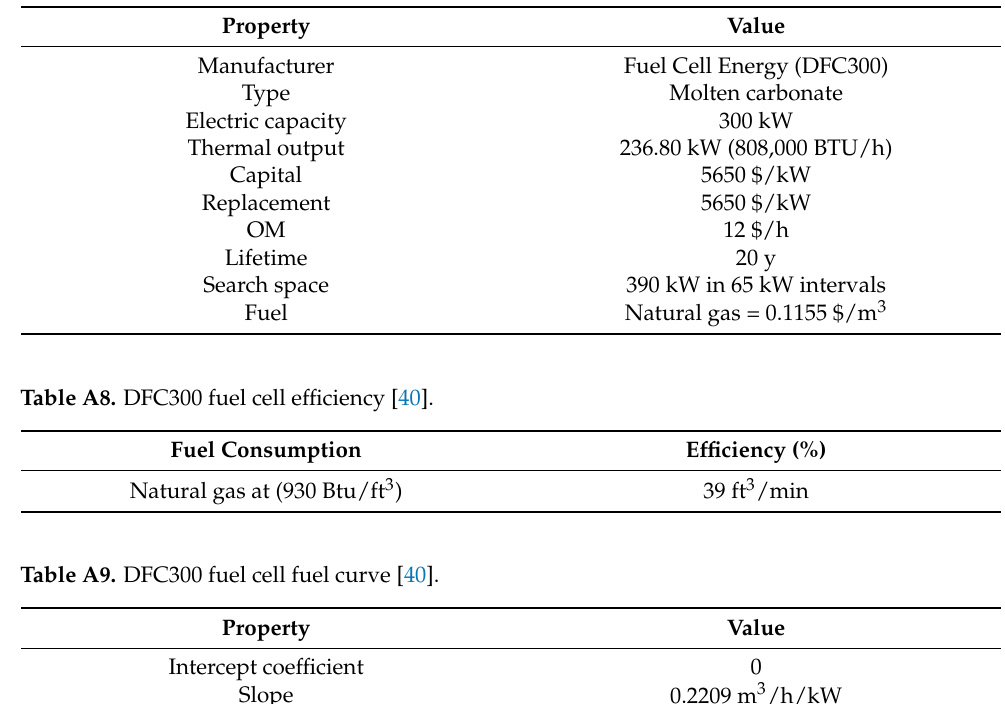
Table A7. Fuel cell parameters for fuel cell [26,40,43].